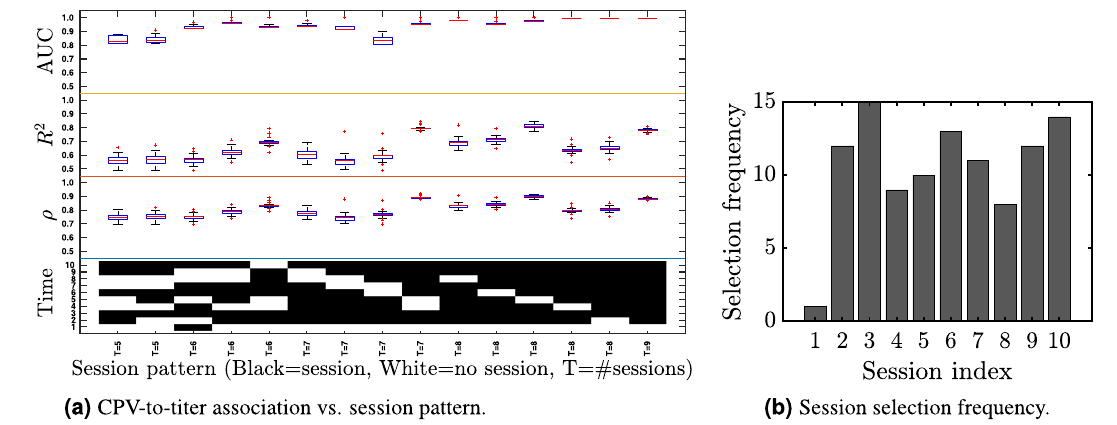
Figure 2. Lumos session timing patterns corresponding to the 15 highest CPV vs shedding correlations. Left: Boxplots of association measures between CPV and shedding for which the cross-validated (leave- one-participant-out) CPV Pearson correlation coefficients are at least 0.69 (the lower endpoint of 95% CI of correlation in Fig. 1d). The measures of association are the Pearson correlation coefficient ρ , the R 2 of linear regression, and the AUC of logistic regression of titers onto CPV. The AUC measures the association of CPV with Low vs High shedding (0,1) labels, where Low and High denote shedding below or above the population median, respectively. The pattern heatmap at bottom indicates the corresponding timing patterns of Lumos sessions with Time 1 corresponding to the initial screening and Time 10 corresponding to the test right before exposure. The number of sessions in each pattern is denoted by T , fewer than T = 7 sessions significantly reduces the association. Right: relative frequency of inclusion of session times 1, . . . 10 in ( a ) (summed over session patterns).